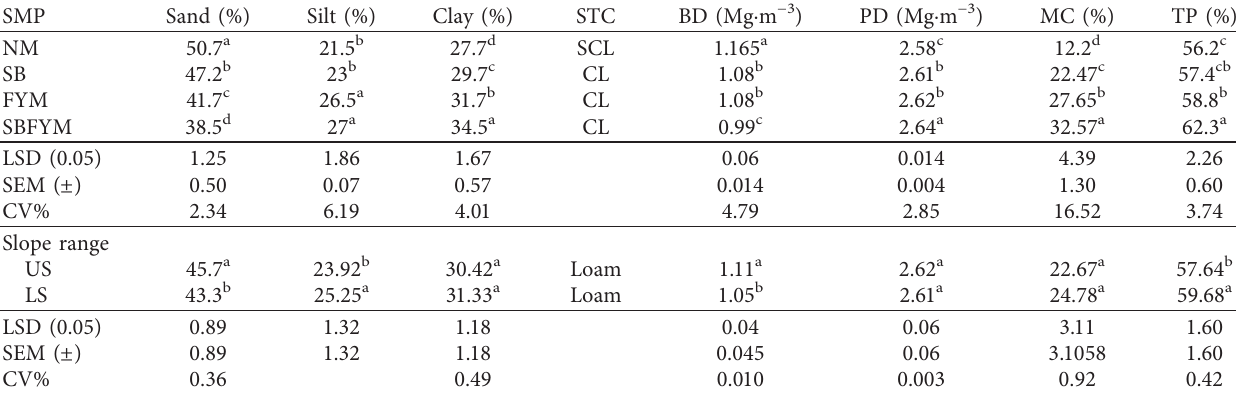
Table 2: Effect of soil management practices and slope range on physical properties of soils in Mawula watershed.